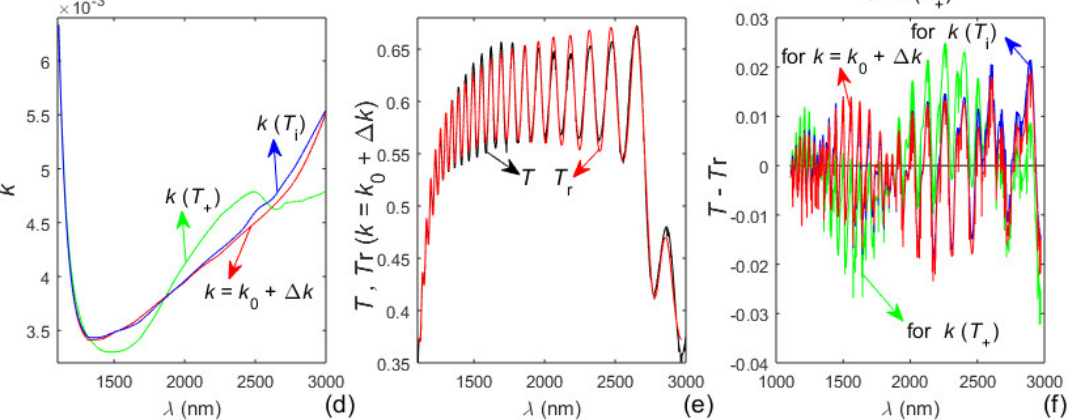
Figure 6. Input data and computed results from the characterization of the As 80 Te 20 film based on the AOEM with d, ∆ d, and m 1 listed in red in Table 1. ( a ) T s ( λ ), T ( λ ), T sm ( λ ), its envelopes T + ( λ ) and T − ( λ ),